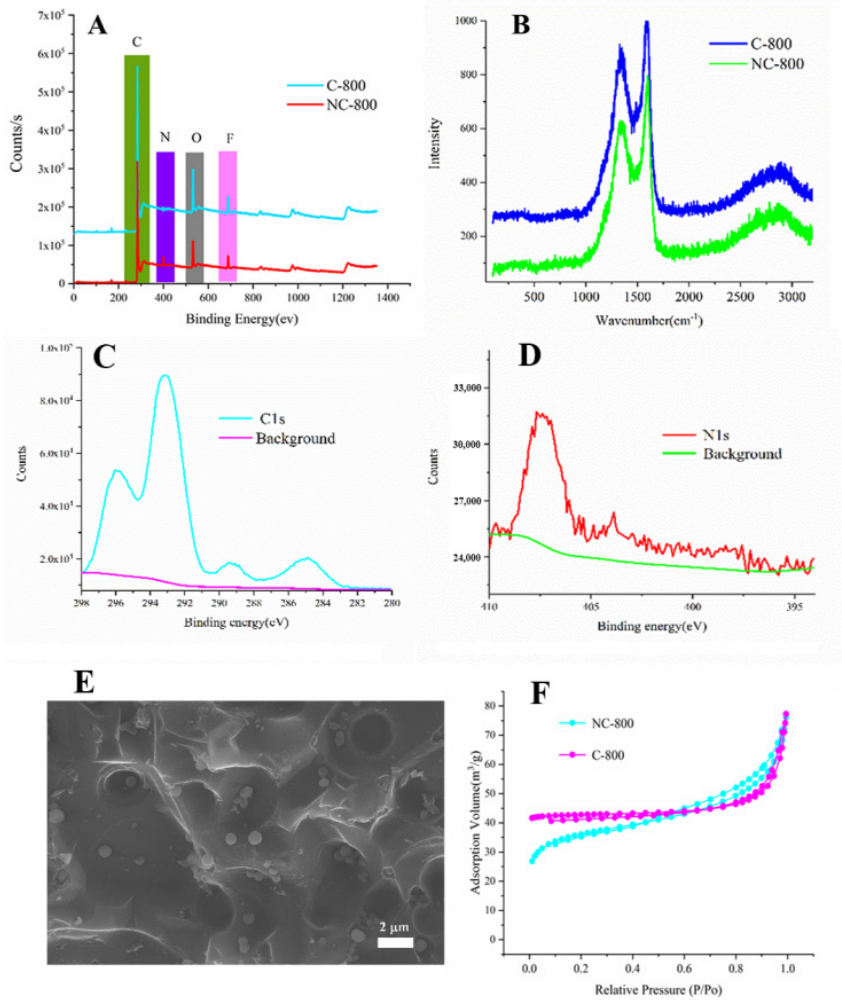
doping, the porous structure of NC-800 is conducive to electronic transmission and storage. The BET surface of NC-800 and C-800 is 115.6 m 2 /g and 9.2 m 2 /g, respectively (Figure 2F).